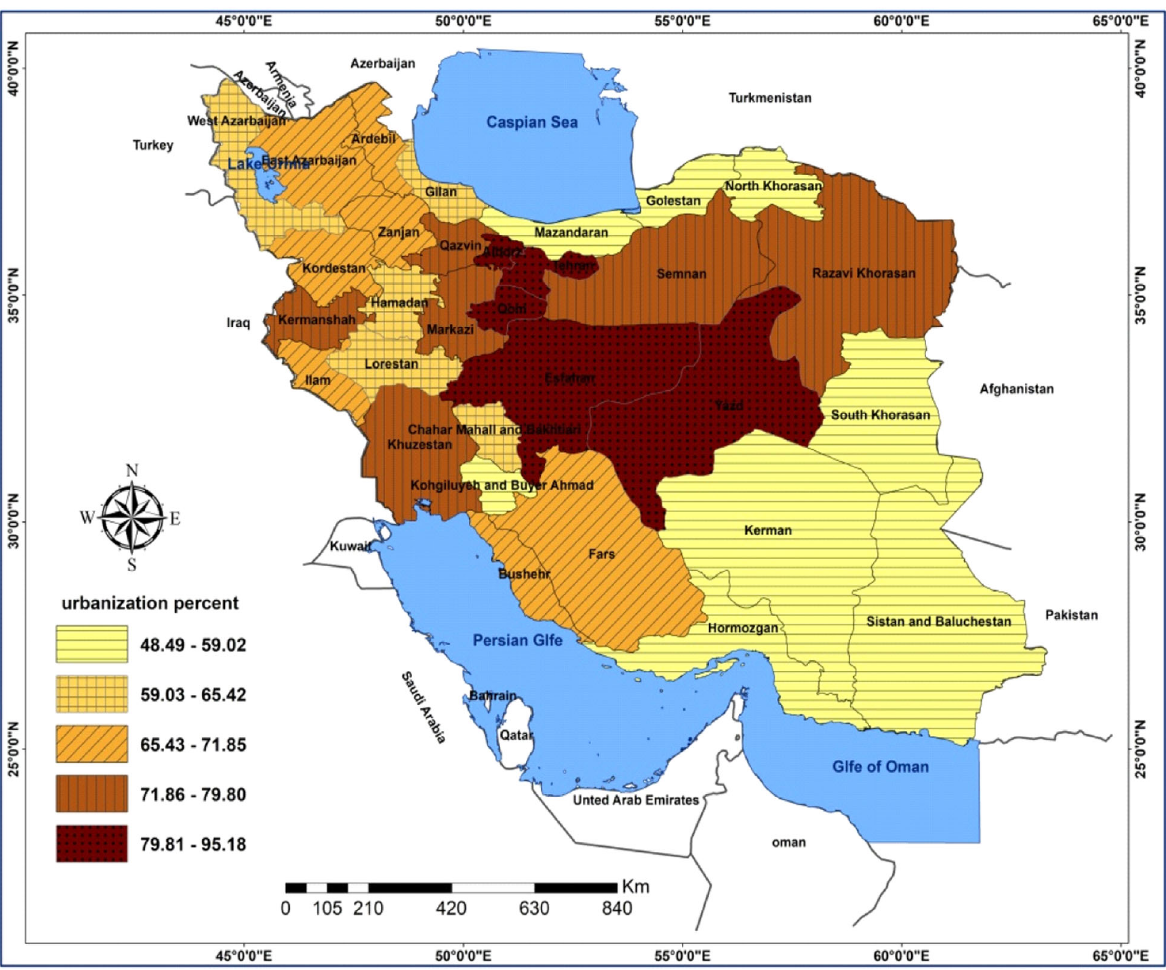
Fig. 6 Geographical distribution of urbanization in Iran (2016). According to 2006 Census, Sistan and Baluchestan (48.49%), Hormozgan (54.71%), and Golestan (53.28) have the lowest rates of urbanization while Qom (95.18%), Tehran (93.85%), and Alborz (92.64) have the highest rate of urbanization. In the fi gure, the geographical distribution of urbanization in Iranian provinces based on 2016 Census is depicted. Figure shows that the percentage of urbanization in Iran has changed. Accordingly, it has increased in all provinces compared to 10 years ago (Sources: Research fi